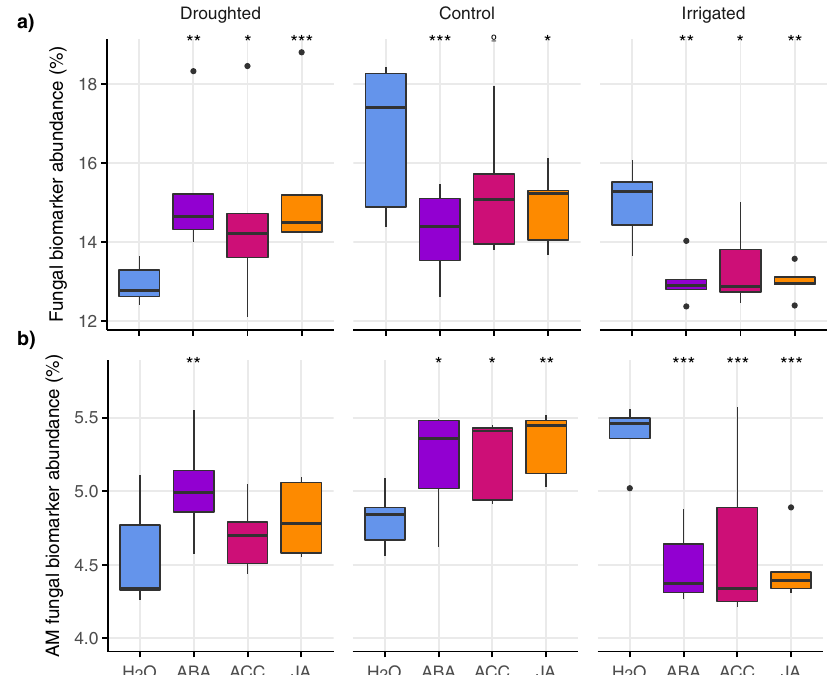
Fig. 3 Fungal biomarker functional groups following phytohormone additions to soils from long-term climate change treatments. Relative abundances of a saprophytic fungi and b arbuscular mycorrhizal (AM) fungi measured in soils collected from control, droughted and irrigated plots in the Buxton Climate Change Impacts Study after incubation for 24 h with abscisic acid (ABA), 1-aminocyclopropane-1-carboxylic acid (ACC), jasmonic acid (JA), or water (procedural controls; H 2 O); boxes denote the 25th and 75th percentiles, and median lines are given for n = 5 replicates based on independent fi eld plots; whiskers indicate values up to 1.5× the interquartile range and dots indicate outliers; effects of hormone application within climate treatments are shown as *** p < 0.001; ** p < 0.01, * p < 0.05 and o for trends at p <